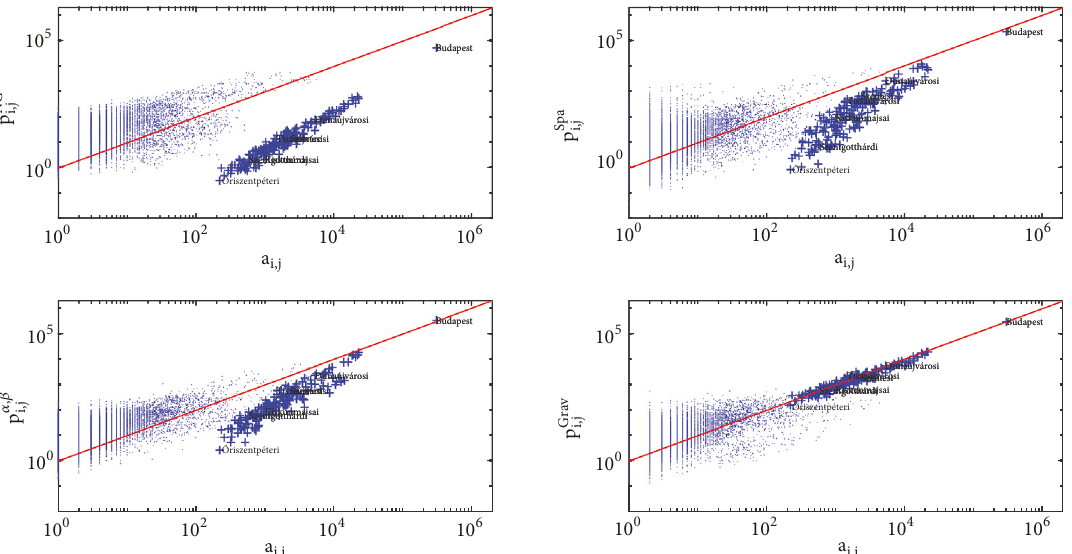
Figure 7: Comparison between the number of the edge weights 𝑎 [2] 𝑖,𝑗 and their estimated values 𝑝 [2] 𝑖,𝑗 generated by different null models at level LAU 1 of the settlement hierarchy when 𝐼 𝑜𝑢𝑡 𝑖 = 𝑘 [1,𝑜𝑢𝑡] 𝑖 and 𝐼 𝑖𝑛 𝑗 = 𝑘 [1,𝑖𝑛] 𝑗 . The + symbols represent the inner connections that form a separate cluster. This plot reflects that, during the aggregation procedure, the qualitative behavior of the models does not change; furthermore, the same phenomena can be observed as in Figure 6.